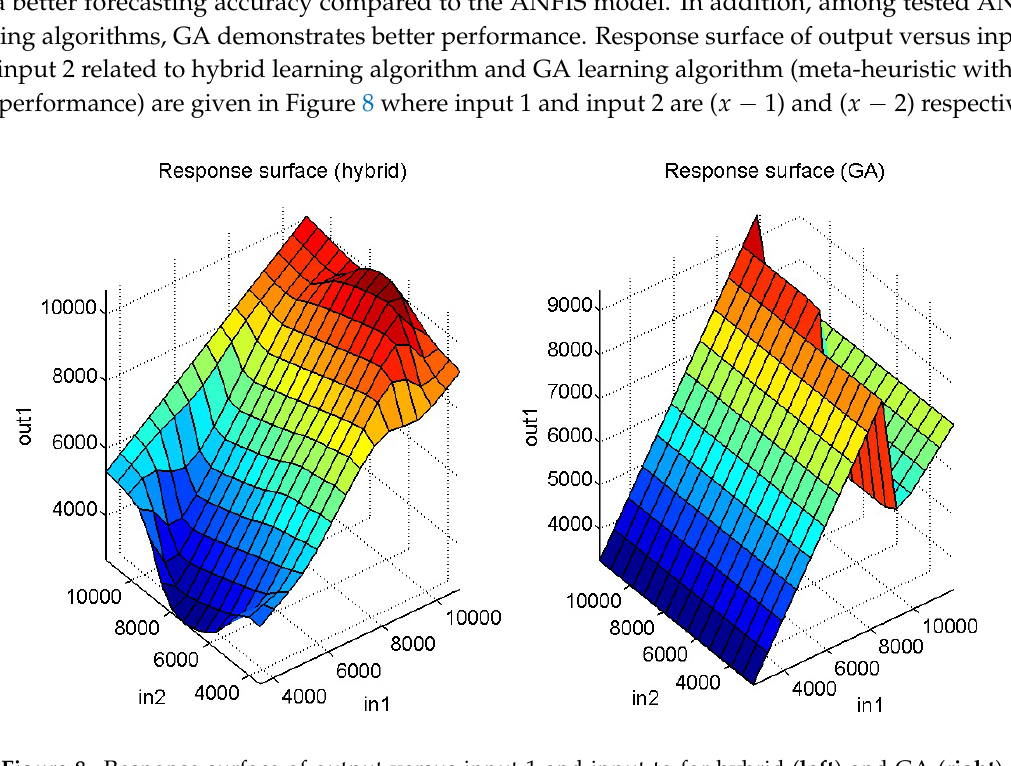
Figure 8. Response surface of output versus input 1 and input to for hybrid ( left ) and GA ( right ) learning